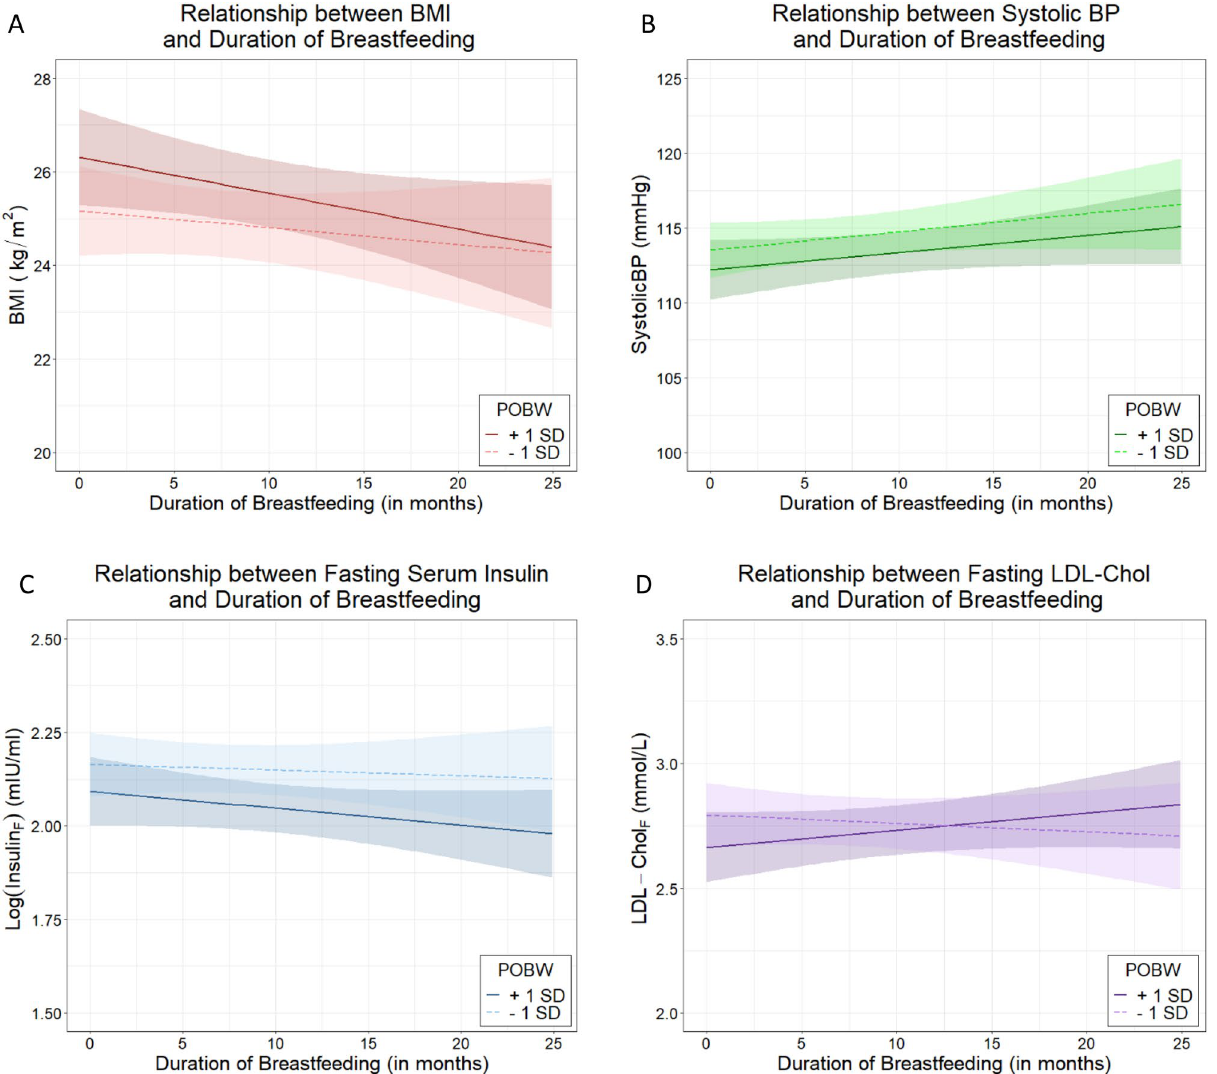
Figure 1. The relationship between duration of any breastfeeding and health measures for POBW that is one standard deviation above the mean, and for POBW that is one standard deviation below the mean. F denotes fasting. ( A ): Body mass index (BMI) at 22 years of age; ( B ): Systolic blood pressure (SBP) at 22 years of age; ( C ): Fasting insulin levels at 22 years of age; and ( D ): Fasting low density lipoprotein cholesterol (LDL-c) at 22 years of age (Figure generated using ggplot2 in Refs. 37,38